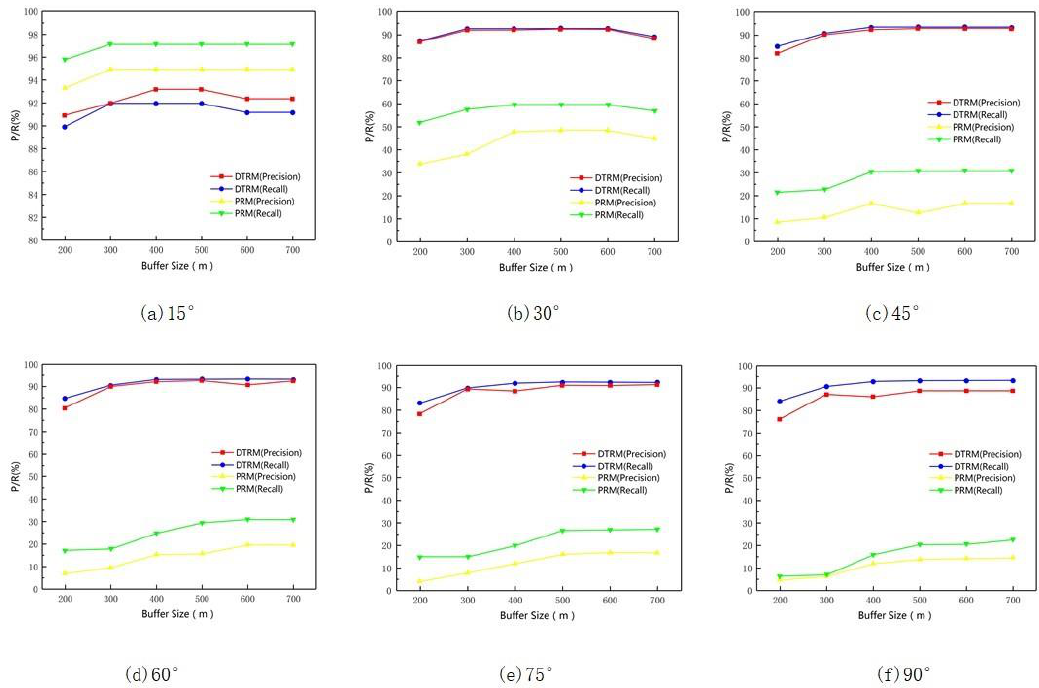
Figure 28. Precision and recall of PRM and DTRM with different buffer sizes and rotation angles. ( a ) 15°, ( b ) 30°, ( c ) 45°, ( d ) 60°, ( e ) 75°, and ( f ) 90°.